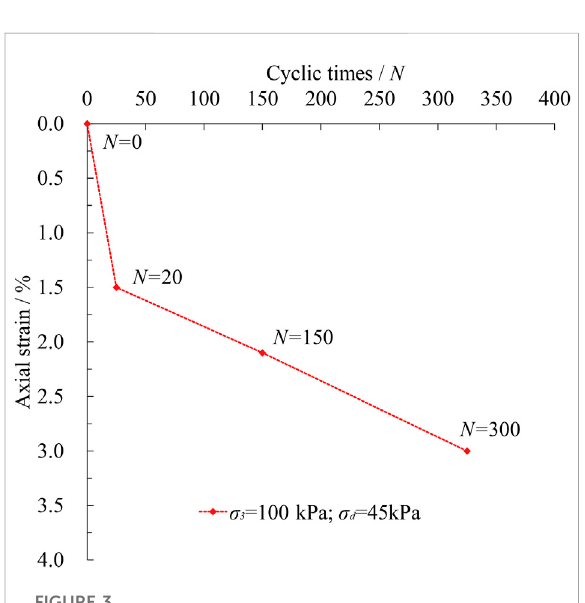
Deformation process of loess samples with cycling vibration and four microstructure observation